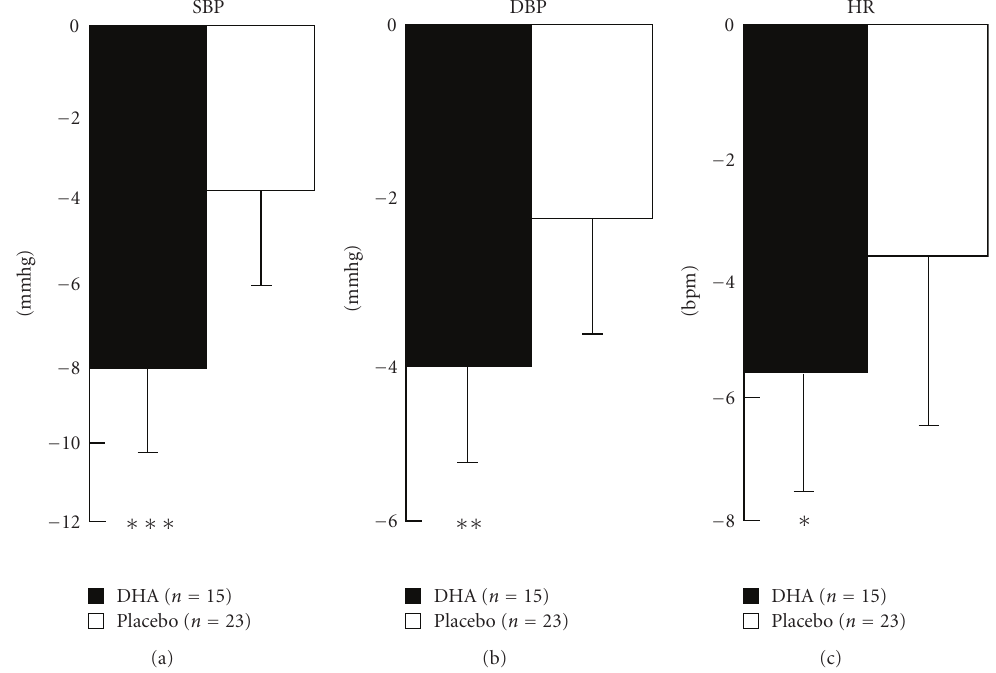
Figure 1: E ff ects of the DHA and placebo on systolic blood pressure (SBP), diastolic blood pressure (DBP), and heart rate (HR). Placebo: Olive Oil-containing bread rolls, DHA: DHA-containing bread rolls. Values are shown as mean ± S.E. of the changes between baseline and after intervention. ∗ P < . 05, ∗∗ P < . 01, and ∗∗∗ P < . 001 compared with the baselines. There was no significant di ff erence between the two groups in either